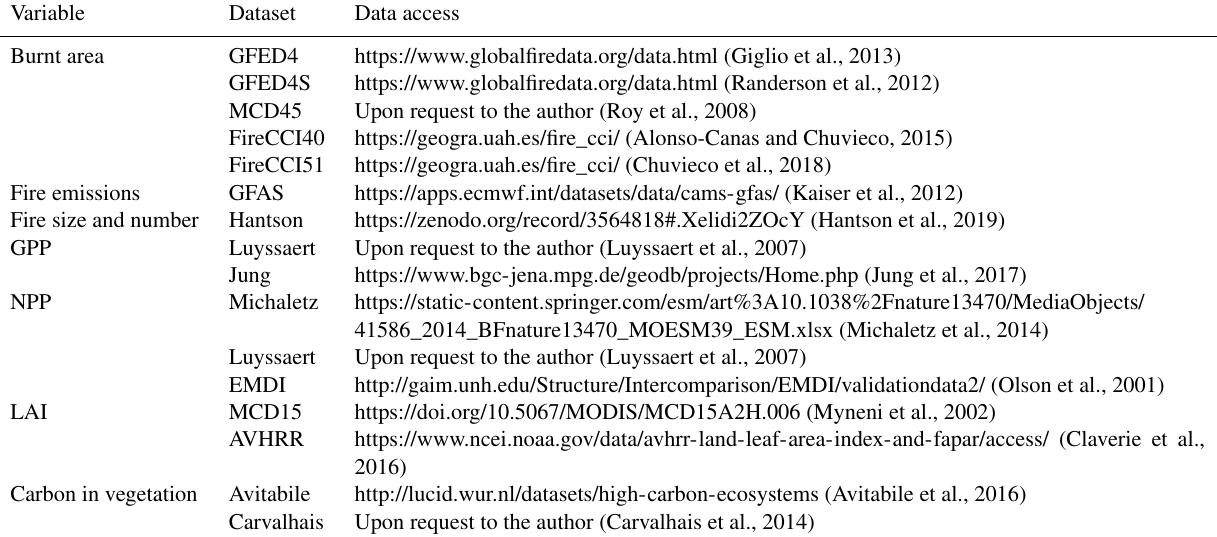
Table A1. Data availability for reference